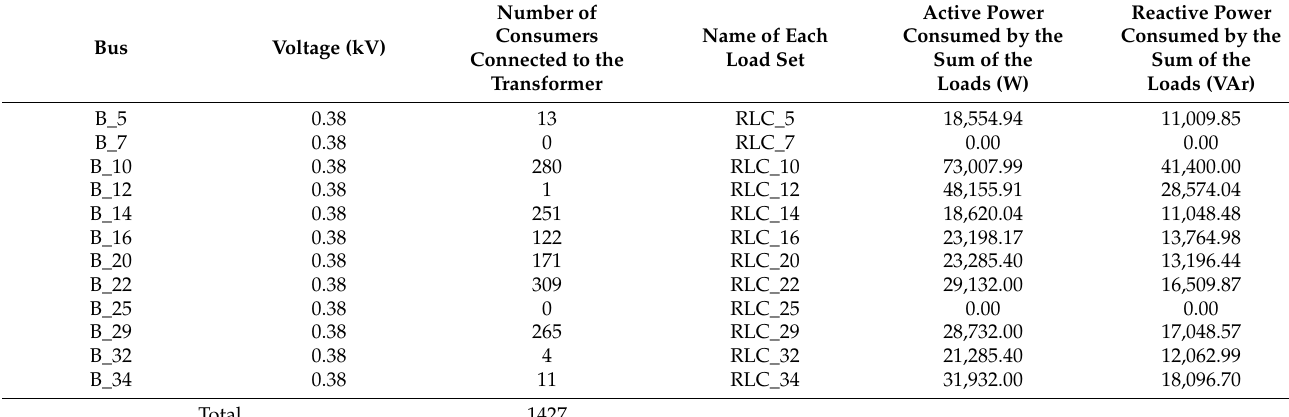
Table 3. Number of consuming units connected to transformer secondary’s which are represented by PQ loads [31], modified.